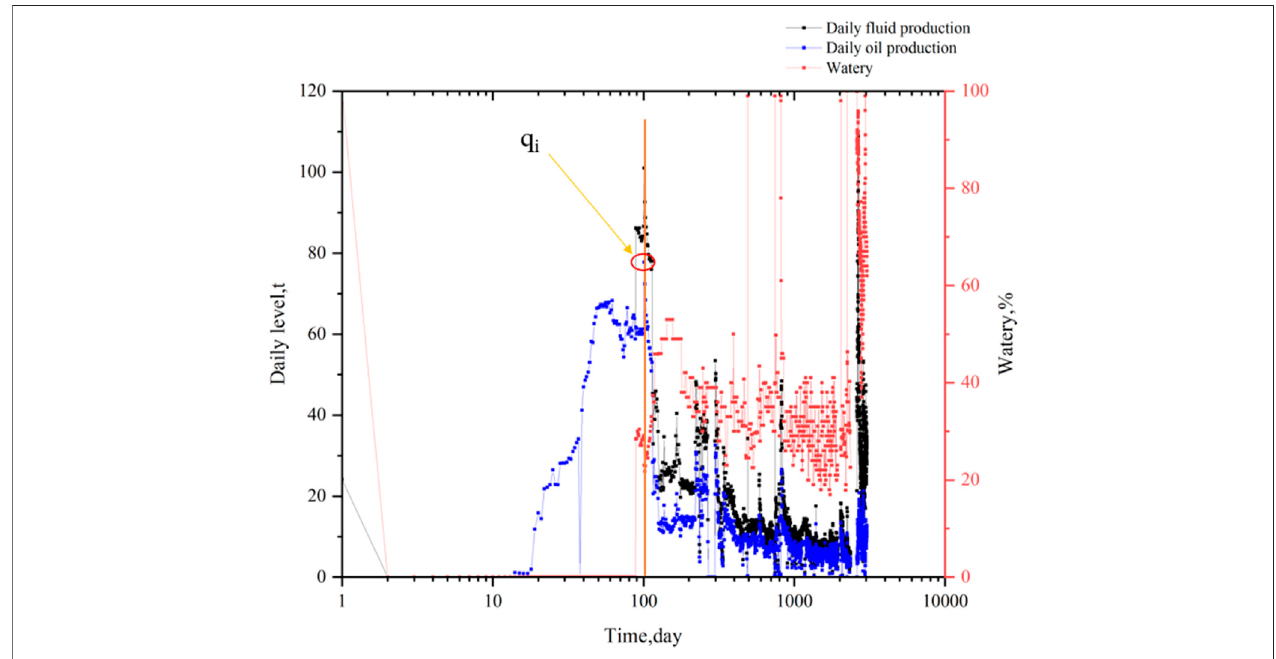
FIGURE 6 | Production performance curve of Well JI172_H.